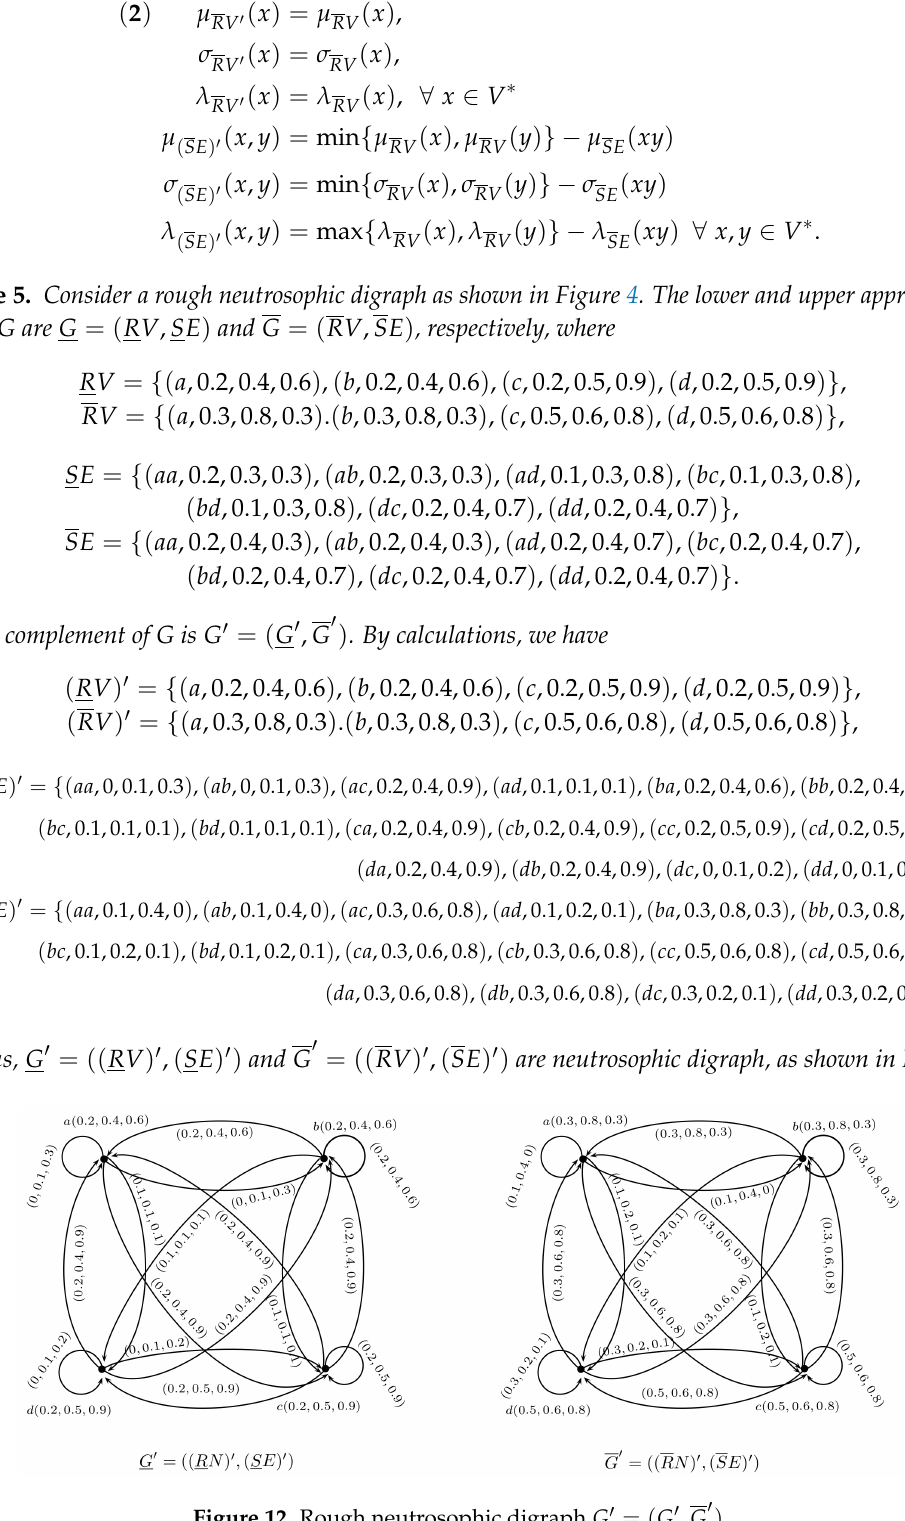
Figure 12. Rough neutrosophic digraph G (cid:48) = ( G (cid:48) , G